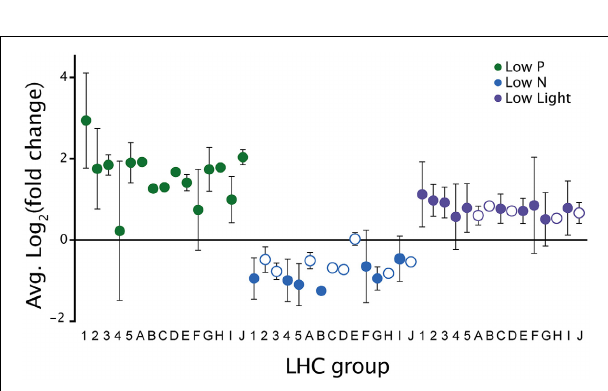
FIGURE 6 | Percentage of transcripts in the top 20 KEGG annotations for significantly downregulated transcripts in the general response and nutrient stress categories. The only shared KEGG annotation between these two categories was calmodulin.